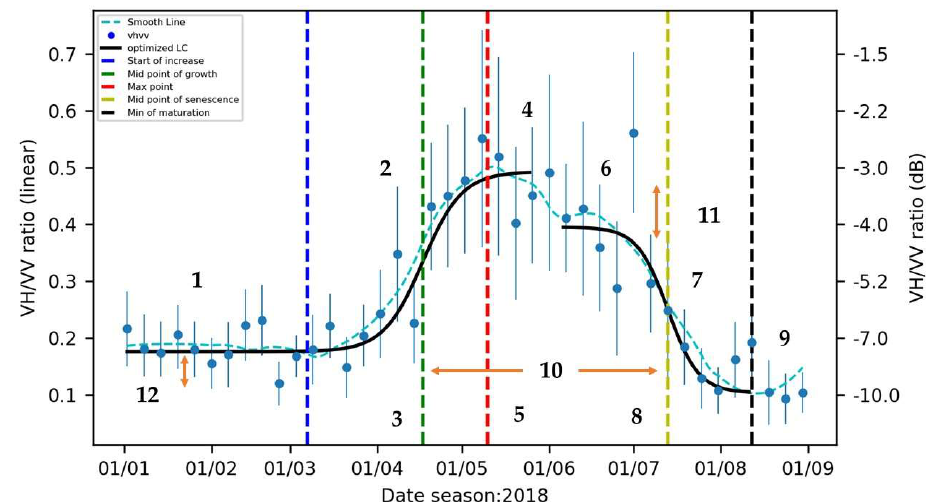
Figure 5. Mean SAR VH / VV ratio for a wheat field (Swayers_4 in 2018) with 228 pixels (1.3 ha), between January and September 2018, showing the standard deviation for each date (n = 41), and displaying 12 parameters as calculated using a smoothed line and two logistic curves (see Table 2). All calculations were completed using a linear scale and the secondary y-axis displays the decibel scale for reference. Combining parameters extracted from the two logistic curves allowed us to derive three additional vegetation development-related parameters (10, 11, and 12 in Figure 5). The period between the two midpoints of the logistic curves (Parameter 10 in Figure 5) was defined as the duration of “full” vegetation, which starts with stem elongation and ends with the reduction of the green canopy and translocation of carbohydrates into the grain during maturation. The difference in baselines is related to the backscatter from the biomass of the crop during tillering. The summary of the extracted parameters and their definitions as well as the associated crop development stage is given in Table 2 .